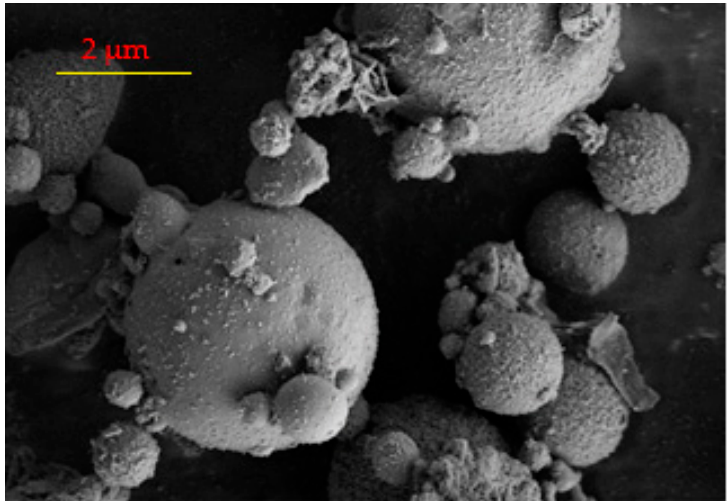
Figure 2. SEM image for raw fly ash. Table 3. The chemical composition for raw fly ash, % atomic.